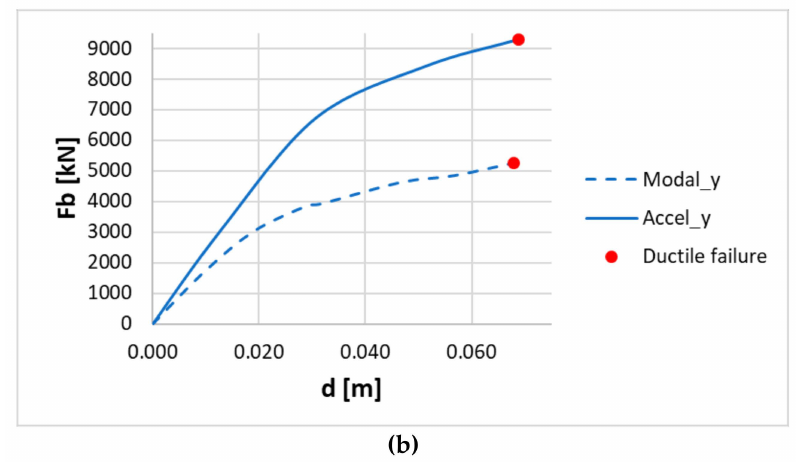
Figure 10. Capacity curves: ( a ) x-direction; ( b ) y-direction.